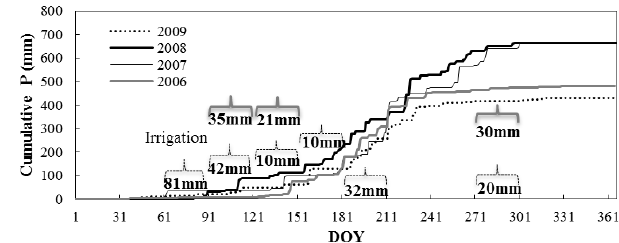
Figure 1. The cumulative precipitation ( P ) and periodic irrigation during 2006–2009; irrigation in 2006 and 2009 were separately rep- resented by the solid and dotted brackets,